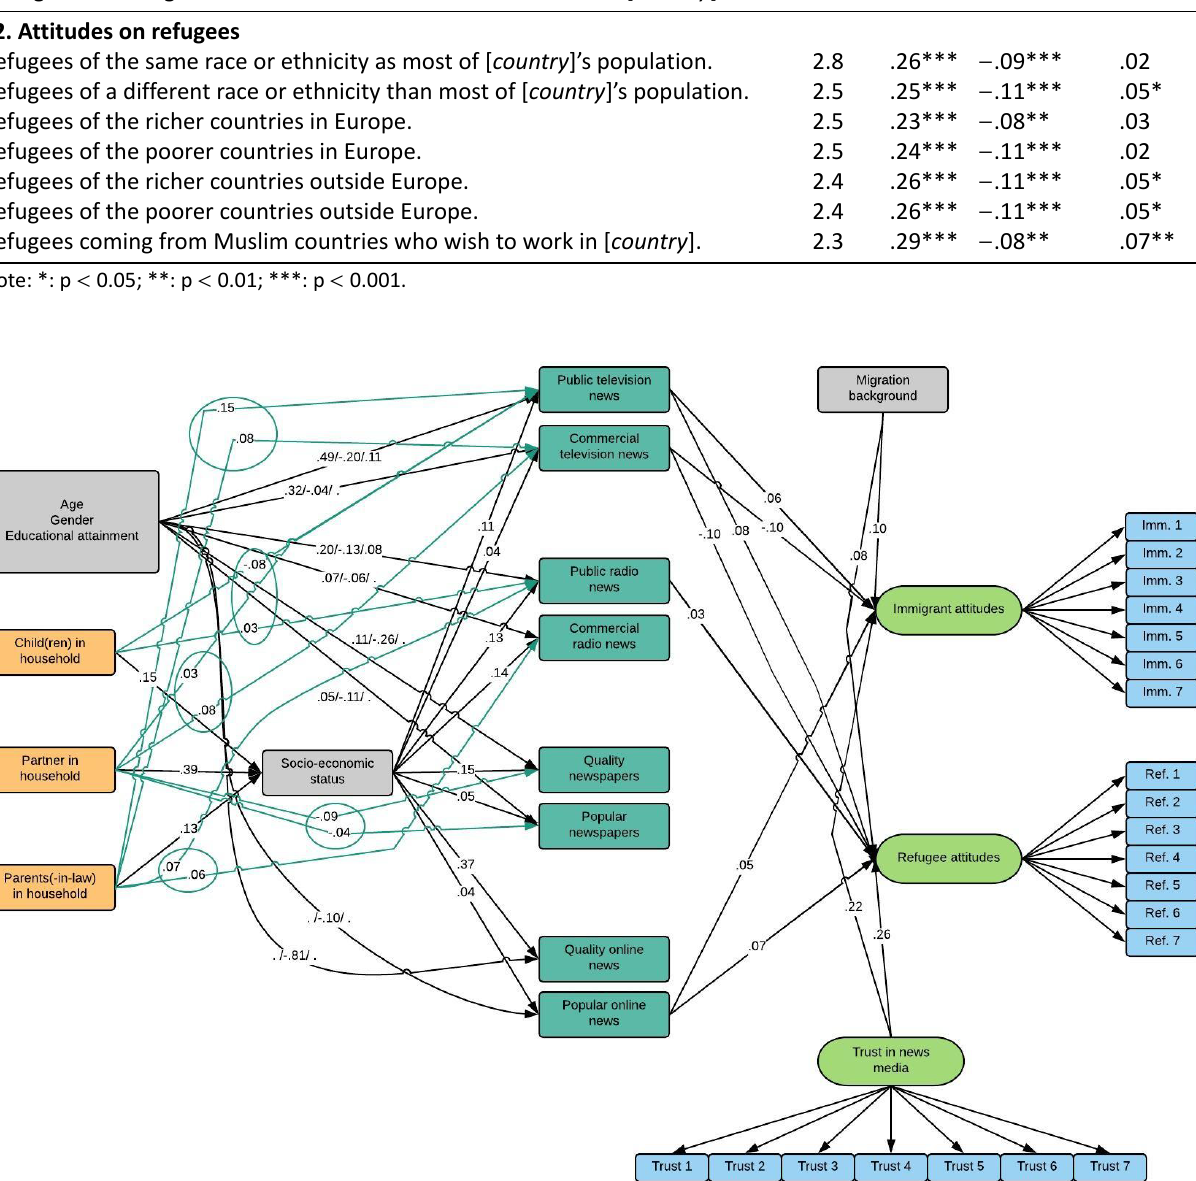
Figure 1. Measurement model for household composition, socio-demographics, news media consumption and trust, and immigrant and refugee attitudes. Note: Only significant relations (p < 0.05) are drawn. Standardized estimates are pre- sented. For full results, please consult the appendix. The reference category for ‘Gender’ = Male, and for ‘Migration back- ground’ = No migration background. Green arrows and circles were drawn to illustrate associations between household composition and media consumption, with the aim of distinguishing them from other